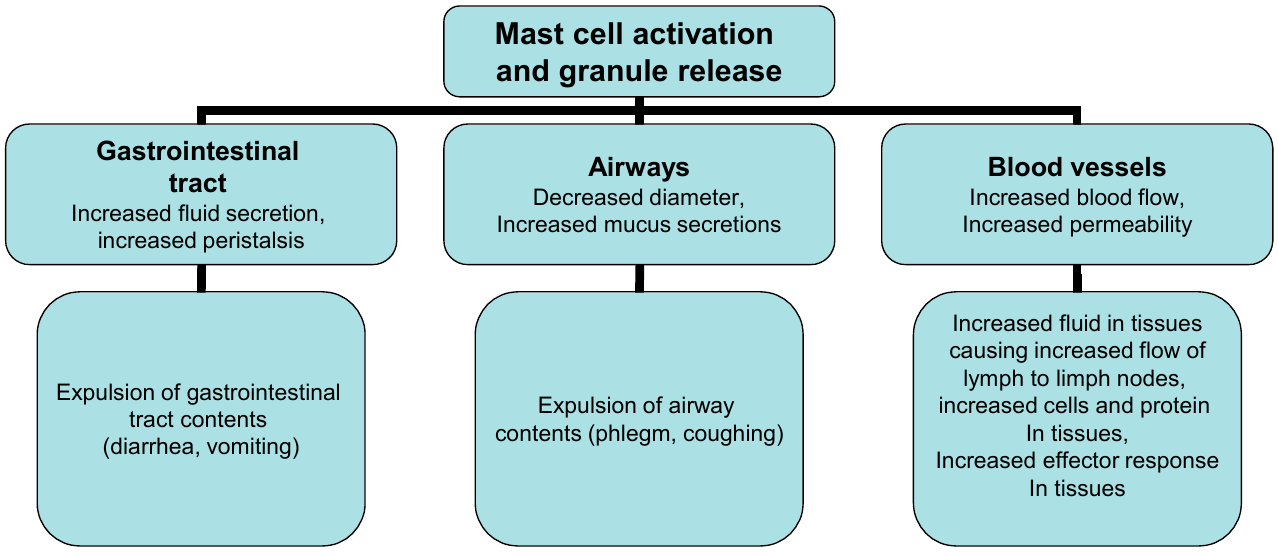
Figure 3. Effector mechanism in allergic reaction.